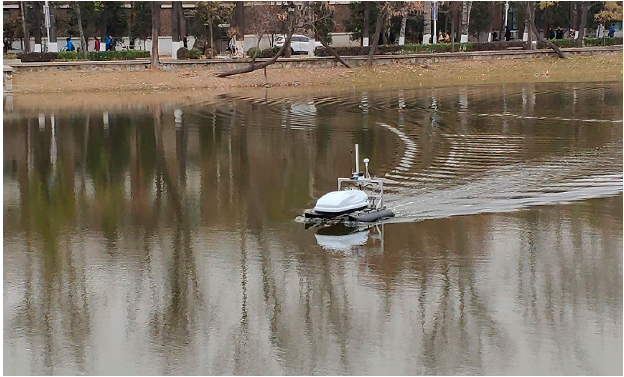
Figure 15. The experimental environment.